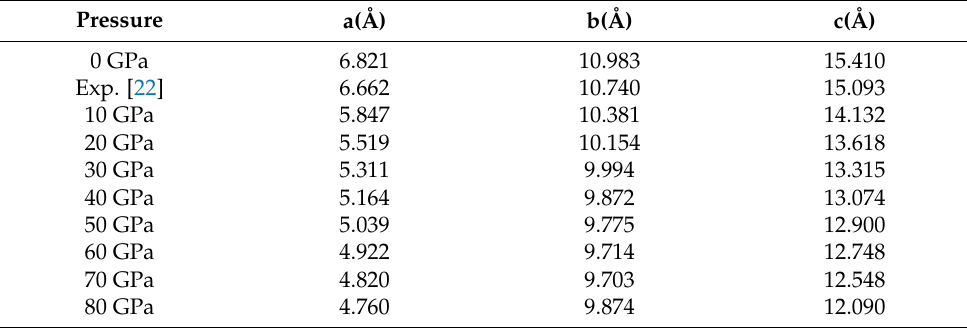
Table 1. The calculated lattice parameters of DNTF under different pressure.